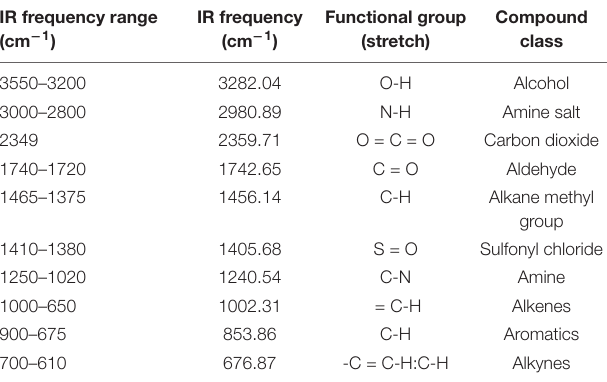
TABLE 2 | Fourier Transform Infrared Analysis (FTIR) analysis of Padina antillarum. IR frequency range (cm − 1 )